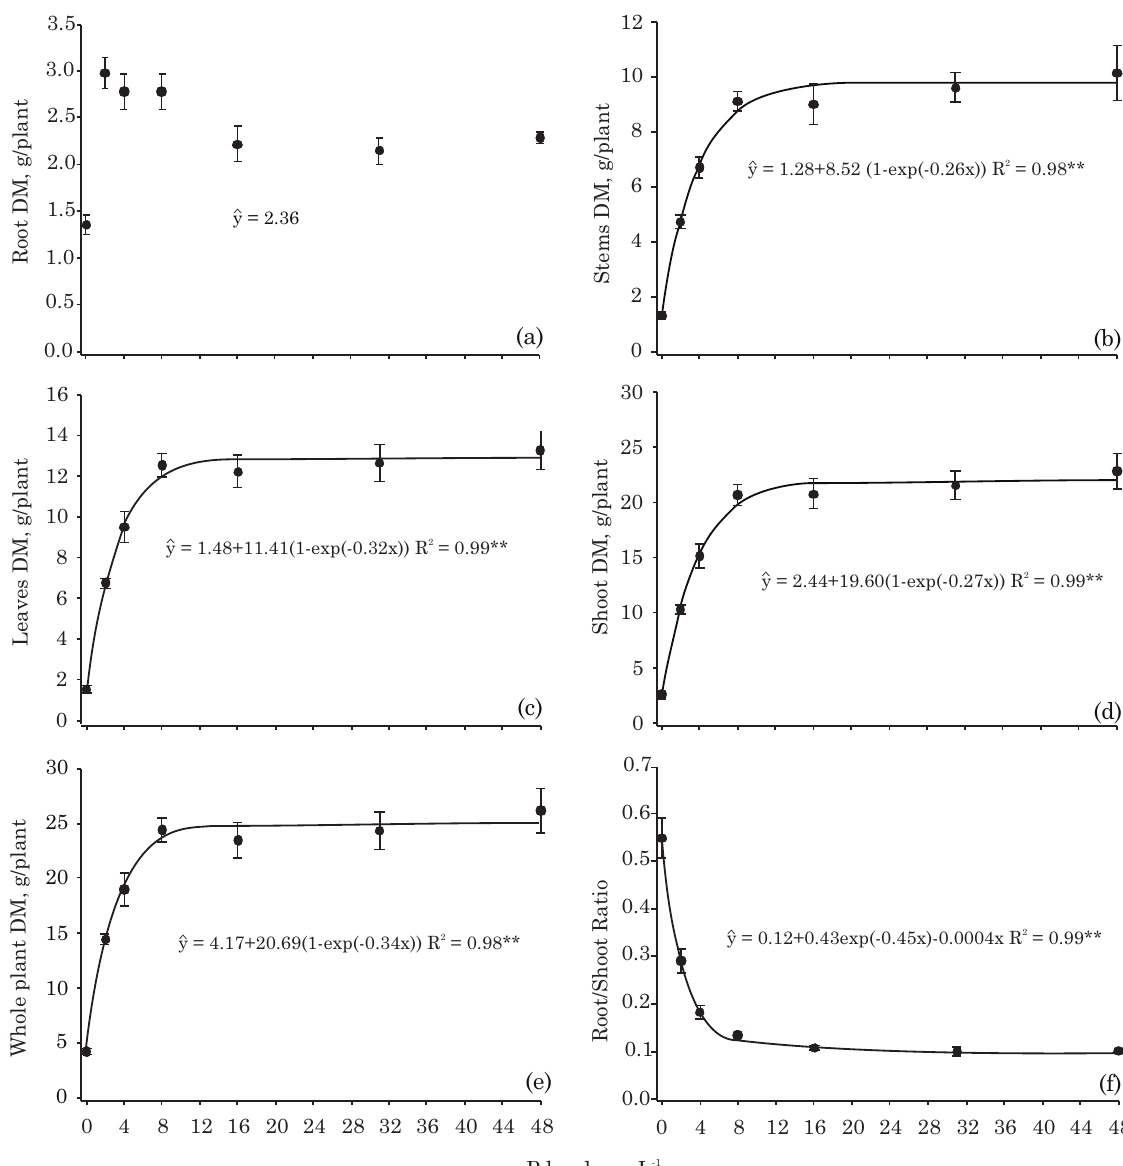
Figure 1. Dry matter (DM) accumulation in roots (a), stems (b), leaves (c), shoot (d), and whole plant (e) and root/shoot ratio (f) in potato plants, cv. Ágata, as affected by P levels in the nutrient solution. * p > 0.05 and ** p > 0.01. Vertical bars represent the standard